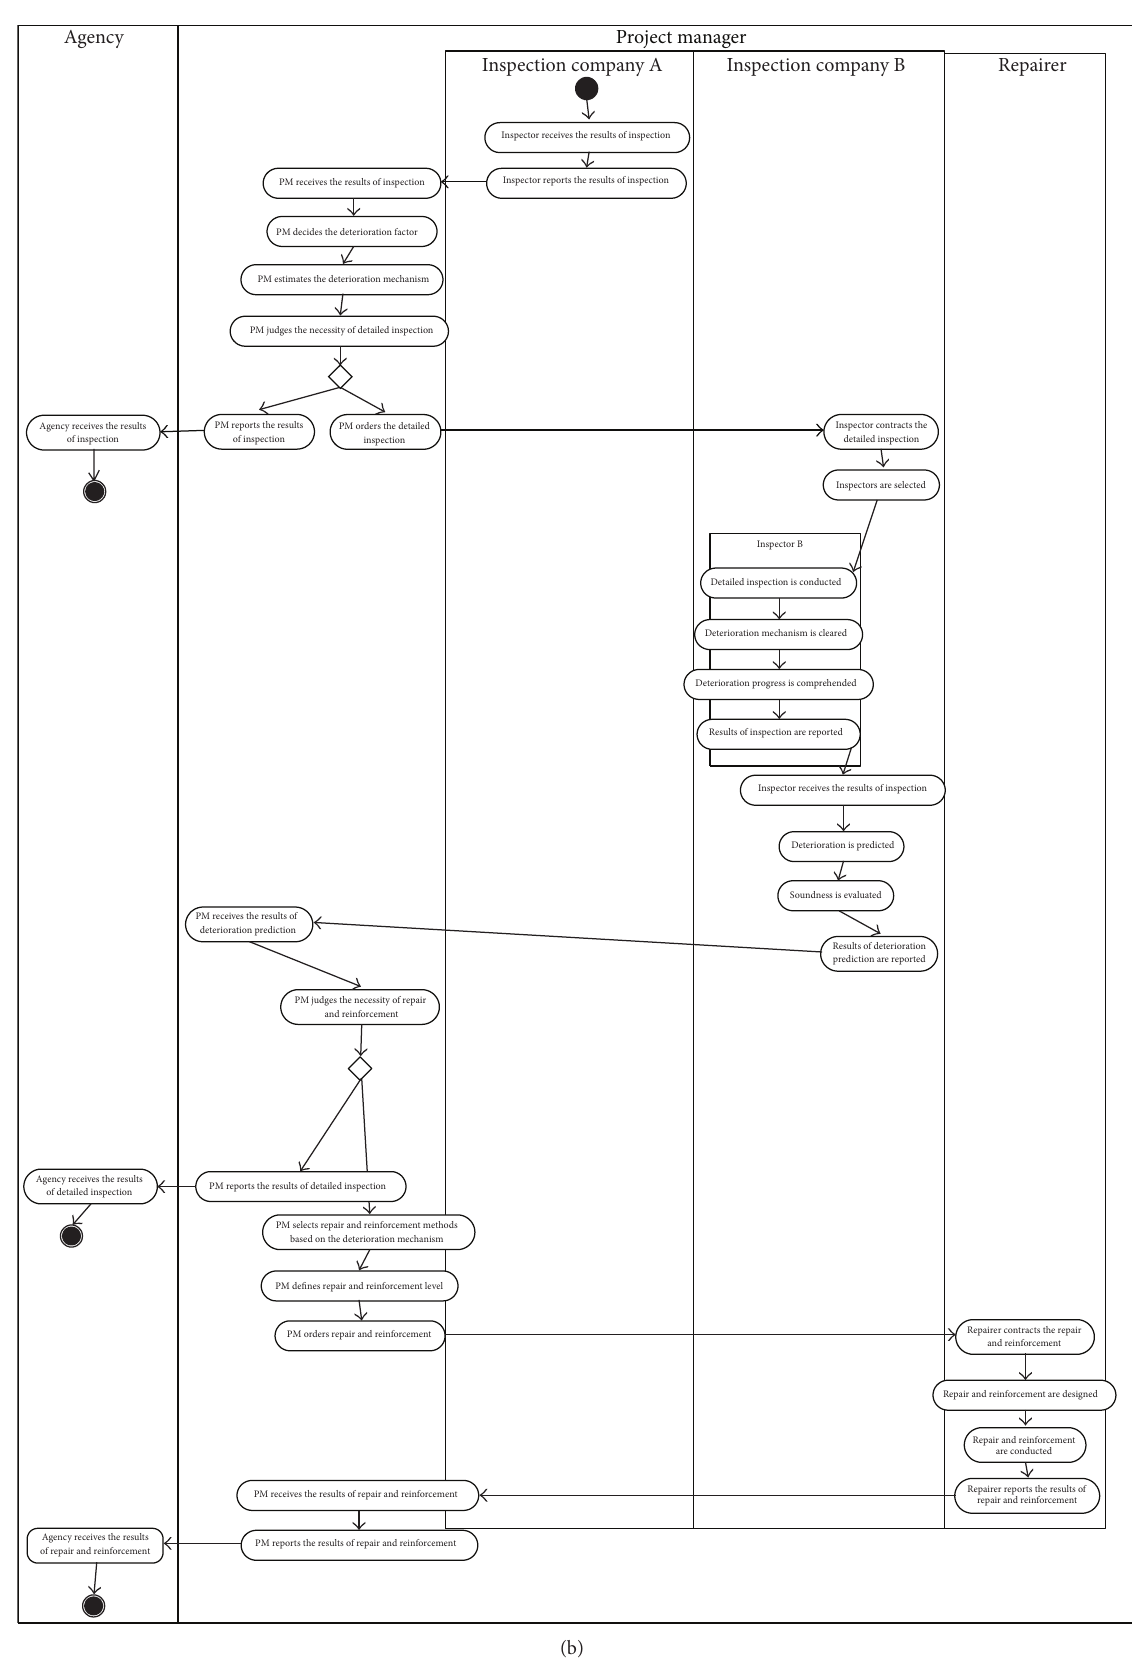
Figure 6: (a) Proposed maintenance flow as utilization scenario (1). (b) Proposed maintenance flow as utilization scenario